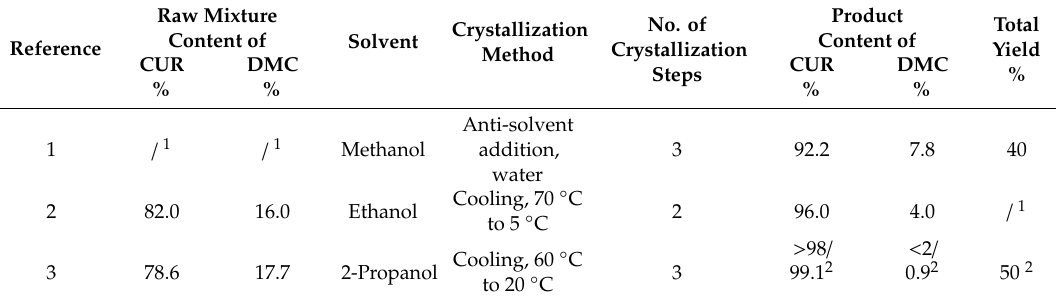
Table 1. Overview of the results of published studies on CUR purification via crystallization: References 1–3 relate to [32–34],